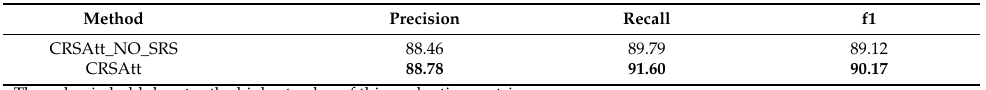
Table 10. Comparison of the model without SRS feature fusion and the full model on the SemEval- 2010 Task 8 dataset.